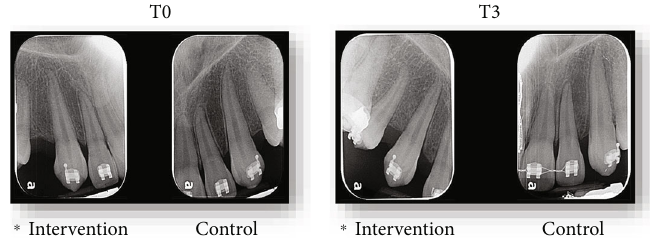
Figure 4: Root length and width measurements of 13 (intervention side) and 23 (control side) in T0 and